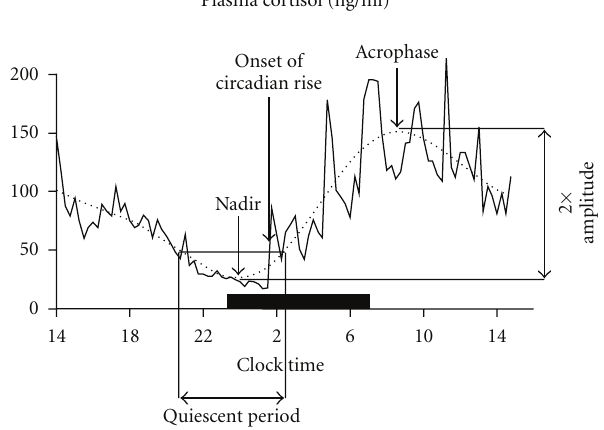
Figure 1: 24-hour individual cortisol profile (solid line).The smoothing curve (dotted line) is calculated to determine the minimum (nadir), the maximum (acrophase), the onset of the circadian rise, and the amplitude (50% of the di ff erence between the acrophase and the nadir) of the cortisol profile. The black bar represents the sleep